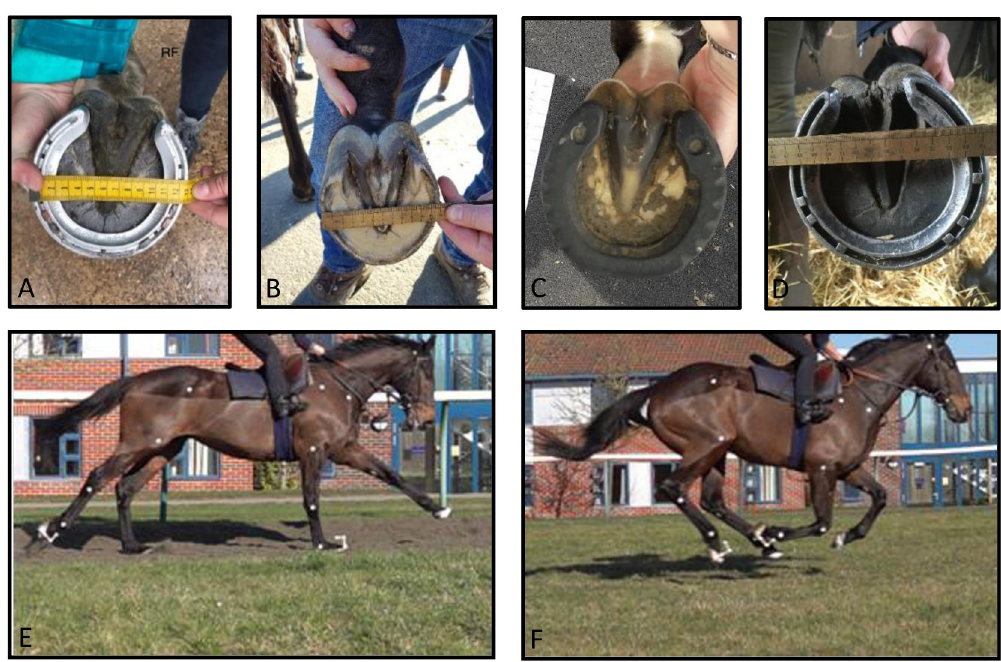
Fig 1. Photographs of the four shoeing conditions and two surfaces used in this study. A) Aluminium raceplate. B) Barefoot hoof. C) GluShu. D) Steel shoe. E) Horse galloping on Martin Collins Activ-Track at the British Racing School. F) Horse galloping on turf track at the British Racing